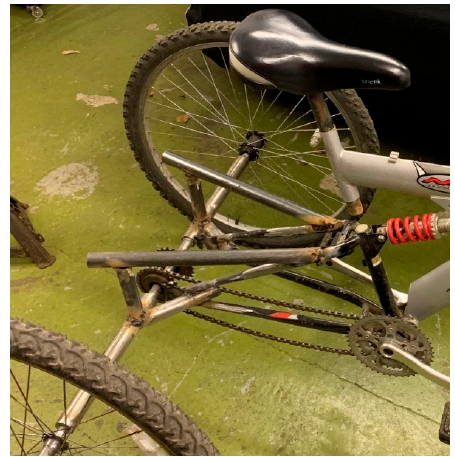
Figure 12. Platform frame assembly.